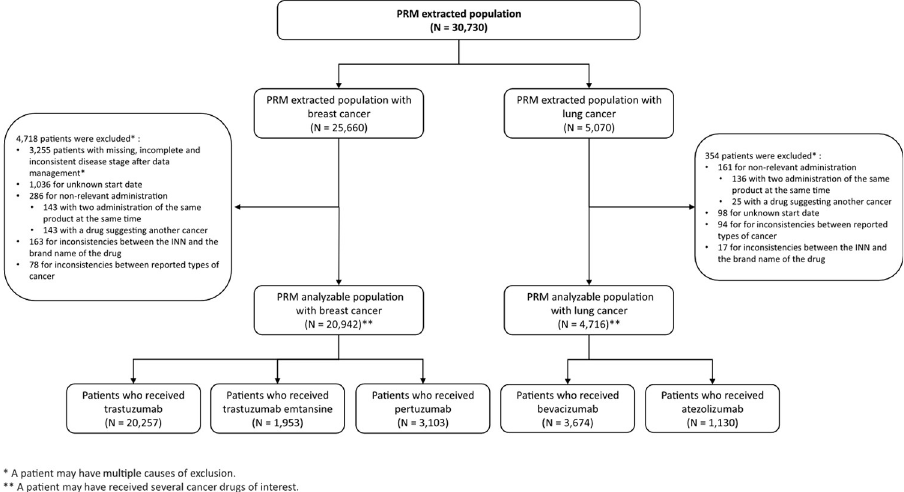
Fig 1. Flow chart. The flow chart represents the different steps of data management leading to the removal of patients from PRM extracted population, populated with data extracted by the French medical centers participating in the PRM program, to PRM analyzable population which allows building retrospective cohorts of breast cancer and lung cancer patients who received at least one injection of a cancer drugs of interest (trastuzumab, trastuzumab emtansin, pertuzumab, bevacizumab or